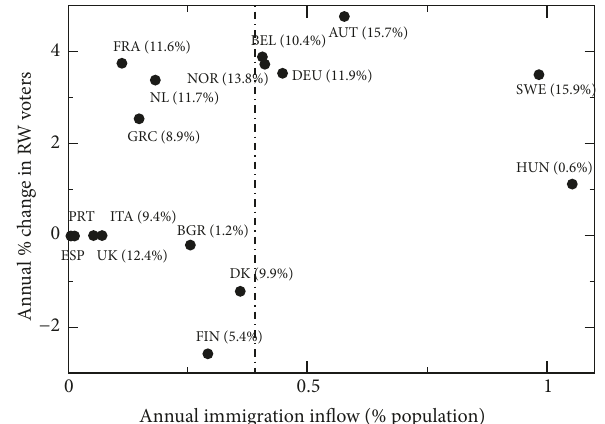
Table 1: Pooled time series cross-section (TSCS) analysis with